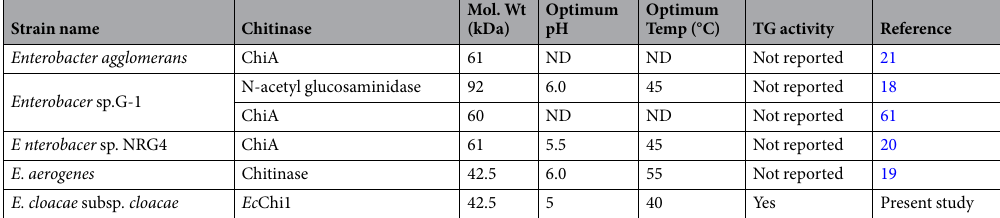
Table 1. Details of chitinases characterized from Enterobacter sp. ND – Not